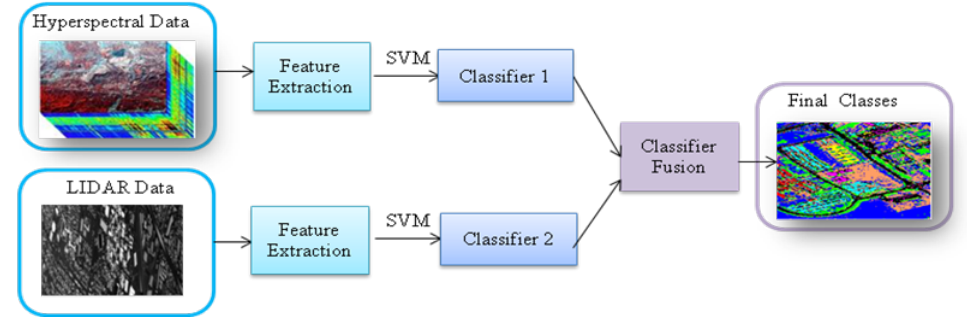
Figure 1. A classifier fusion system for fusion of hyperspectral and LIDAR data